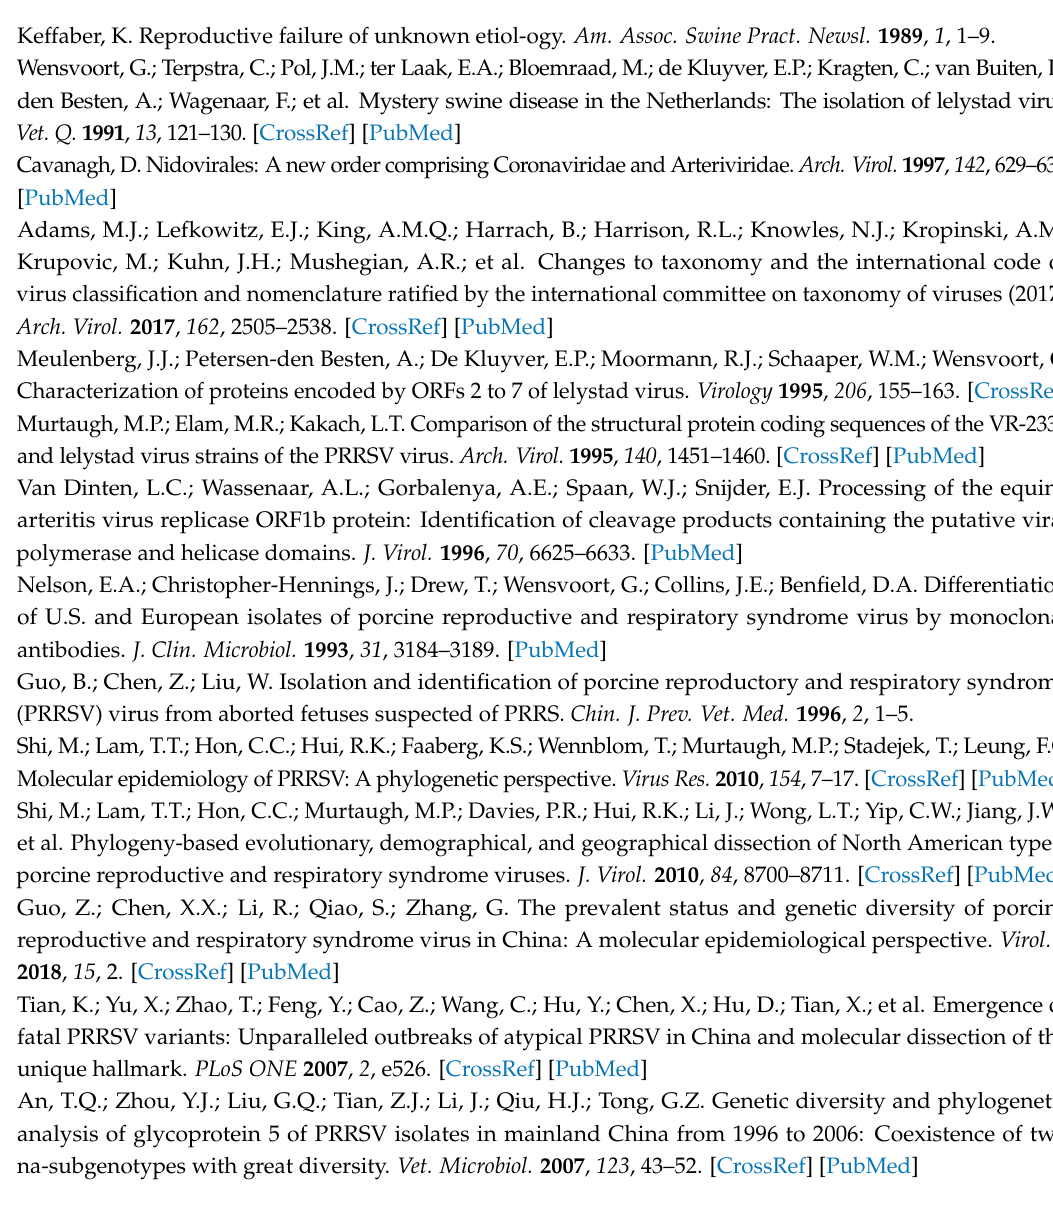
Table S1: Information on the 40 reference PRRSVs downloaded from